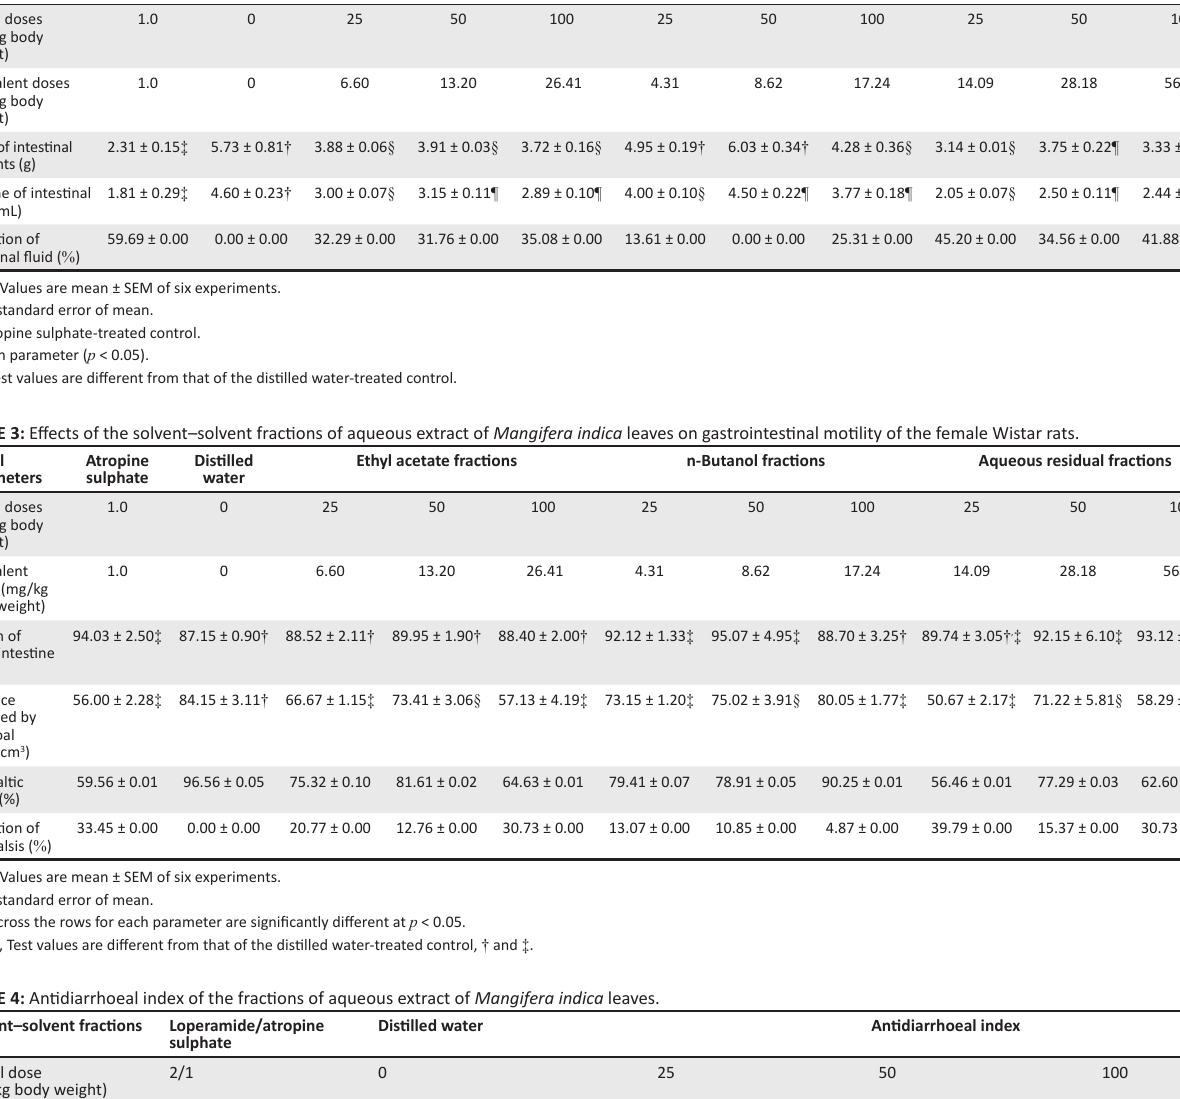
Equivalent doses (mg/kg body